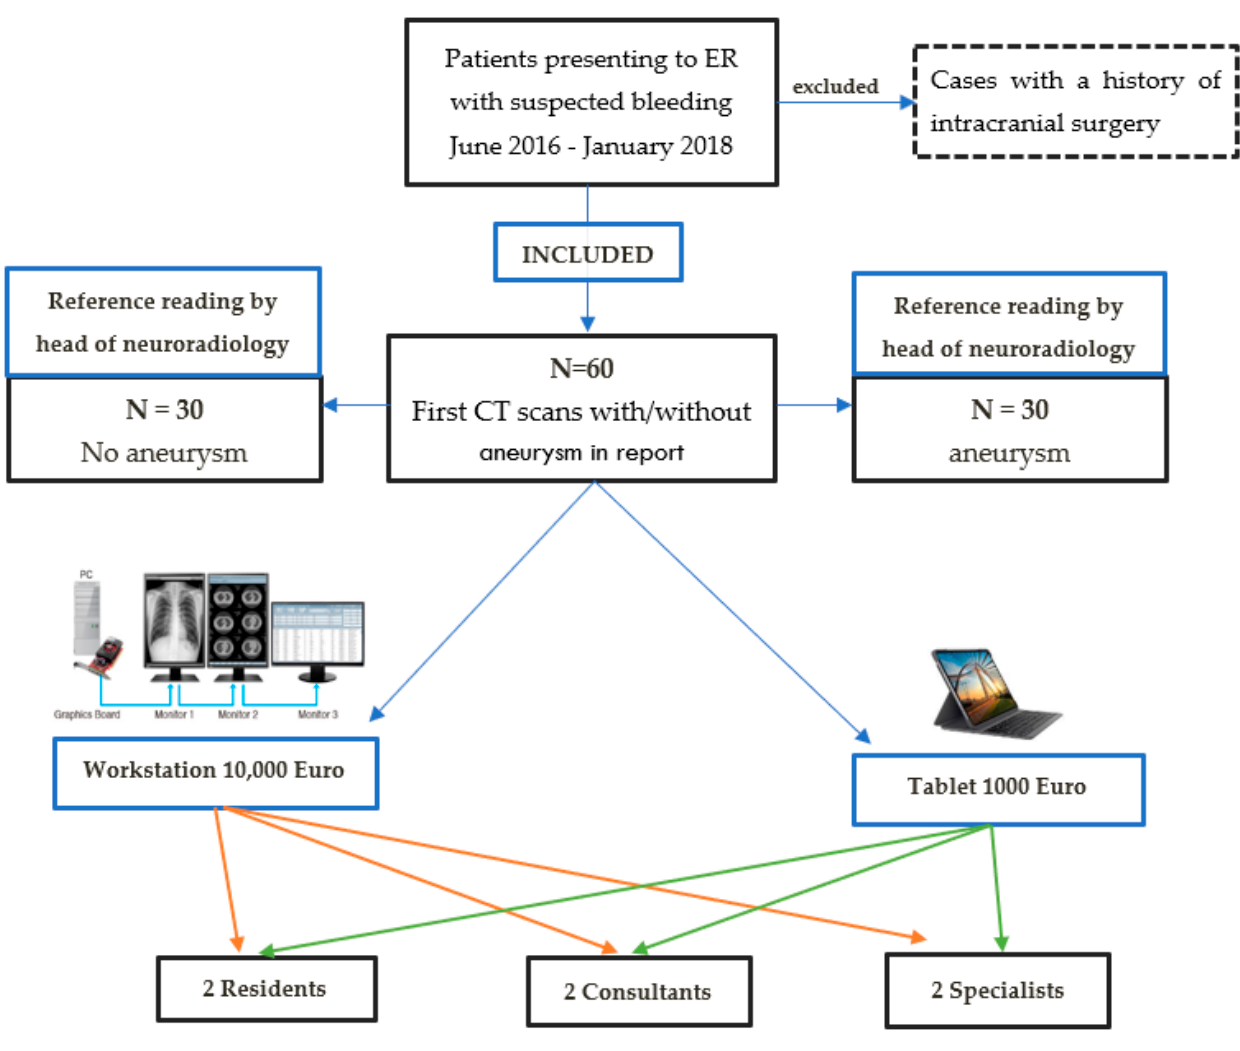
Figure 2. Study design.